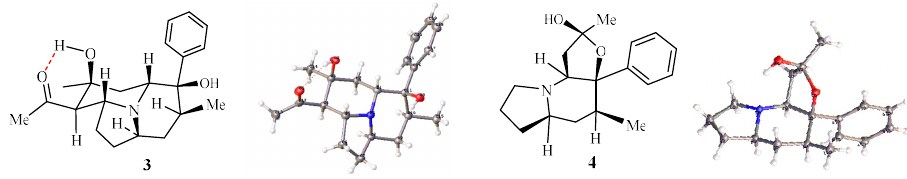
Figure 2. X-ray crystal structure of 3 and 4 .